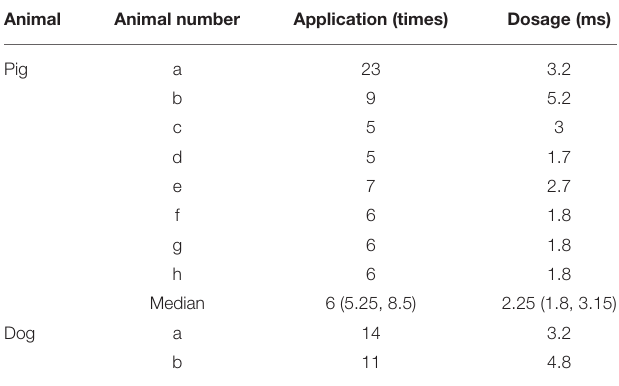
TABLE 1 | Pulsed field applications and